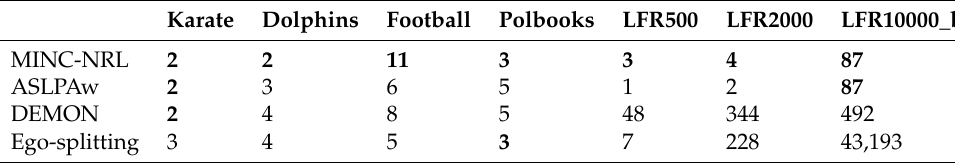
Table 6. CN of MINC-NRL compared with other algorithms.